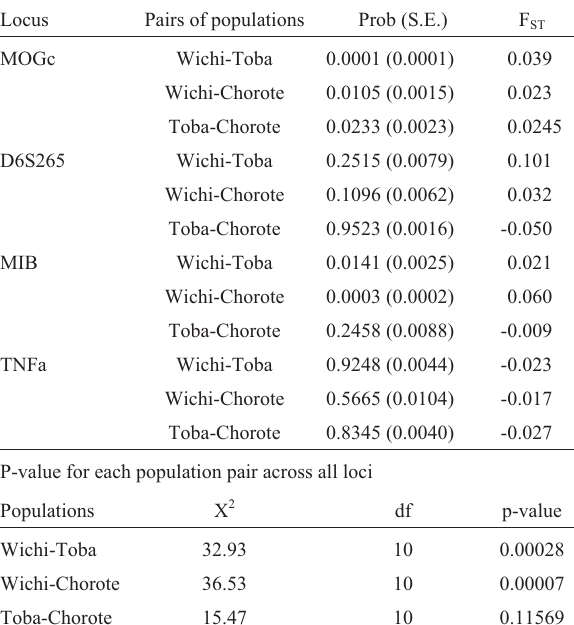
Table 3 - Gene diversity values for each of the four STRs in the three populations studied. Wichi Toba Chorote